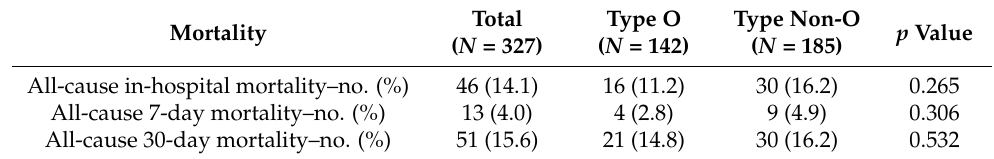
Table 4. Primary